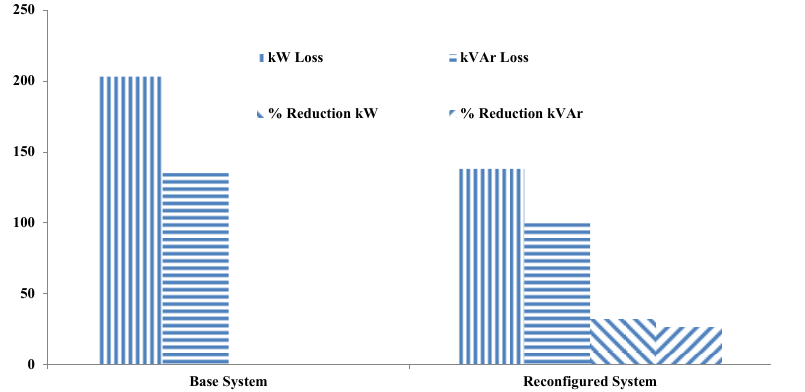
Figure 6. Losses of base and reconfigured distribution system.